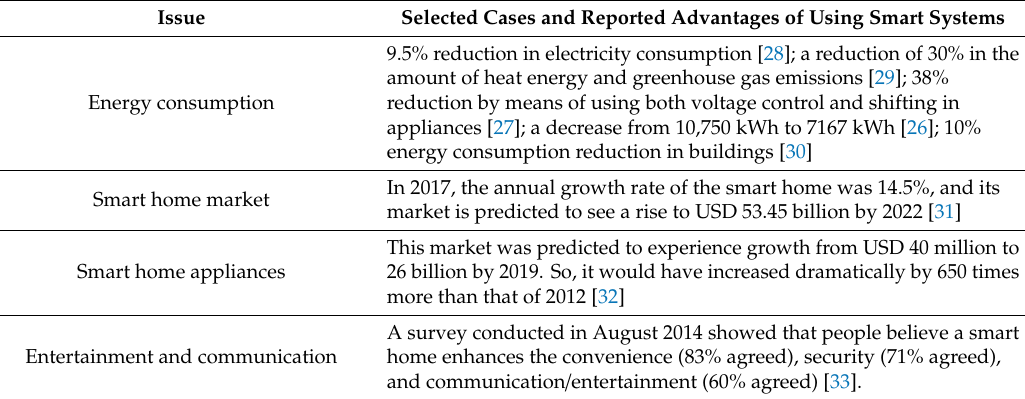
Table 2. Evidence of the use of smart systems globally for various aspects of smart